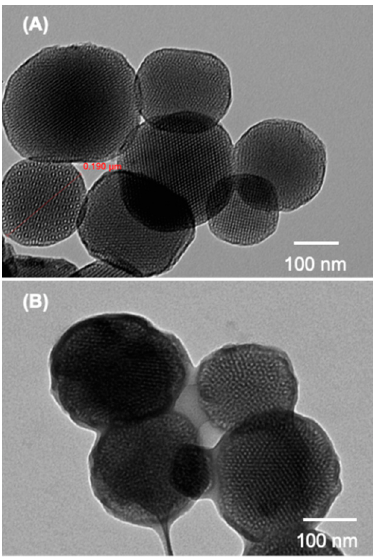
Figure 2. TEM images of fabricated mesoporous silica nanoparticles. ( A ) TEM image of MSNs, as prepared. ( B ) TEM image of PTBAEMA-b-PEGMEMA anchored MSNs.